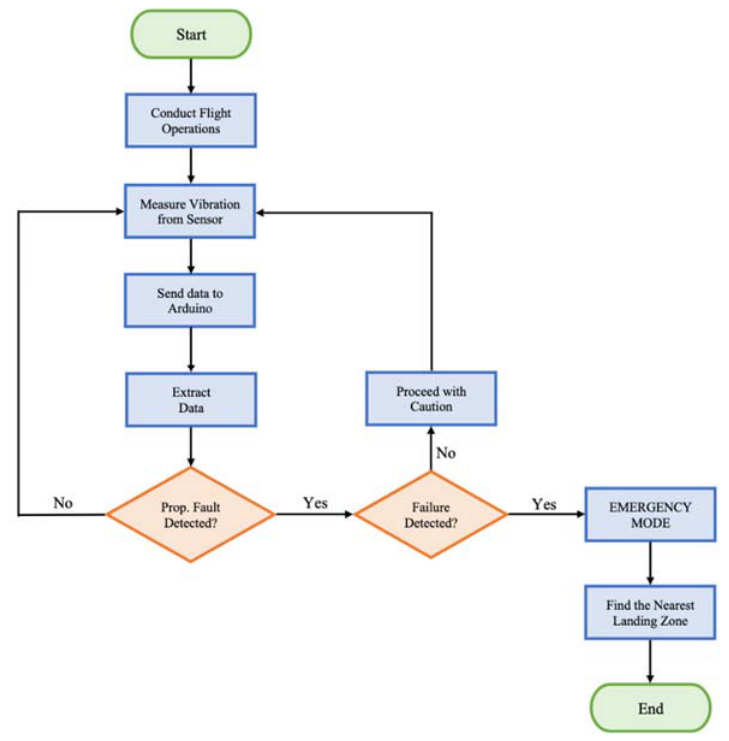
Figure 5. UAV Failure Detection System Flowchart.